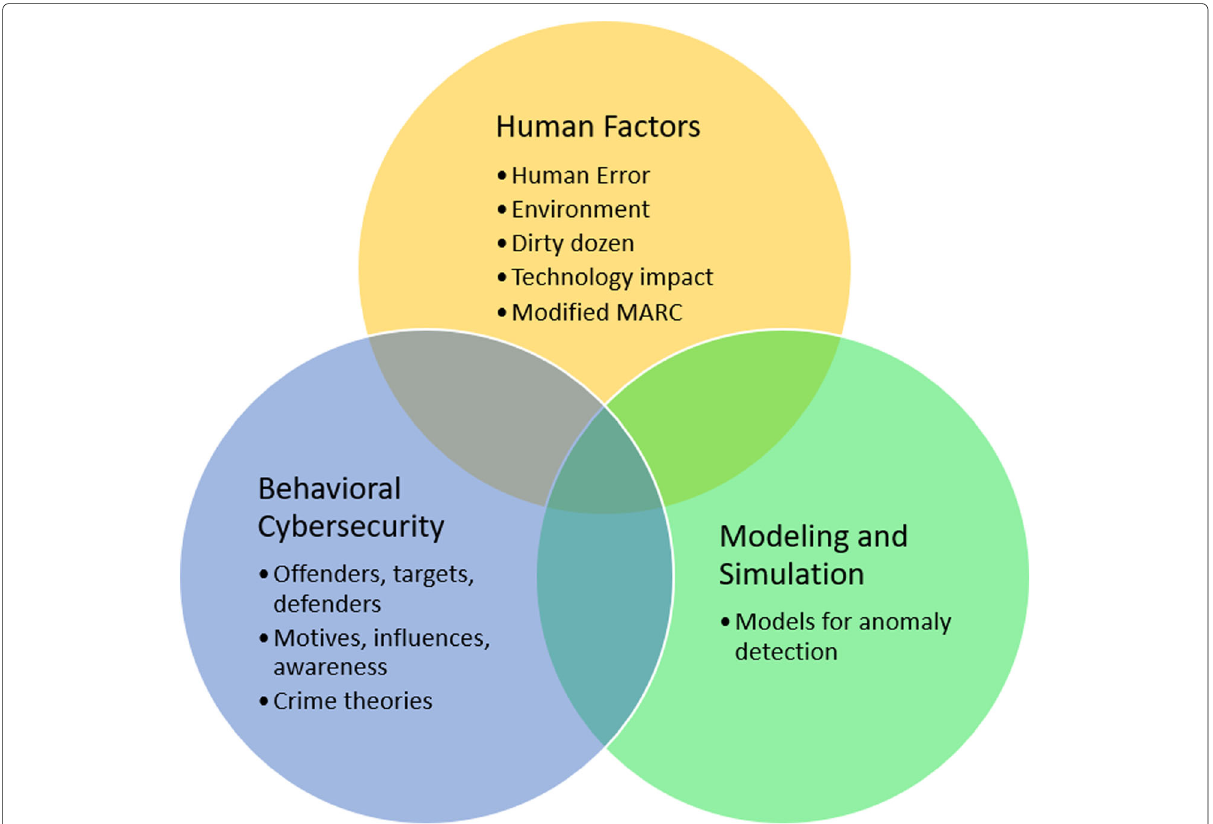
Fig. 2 Venn diagram for the interdisciplinary framework, based on Caulkins (2017)